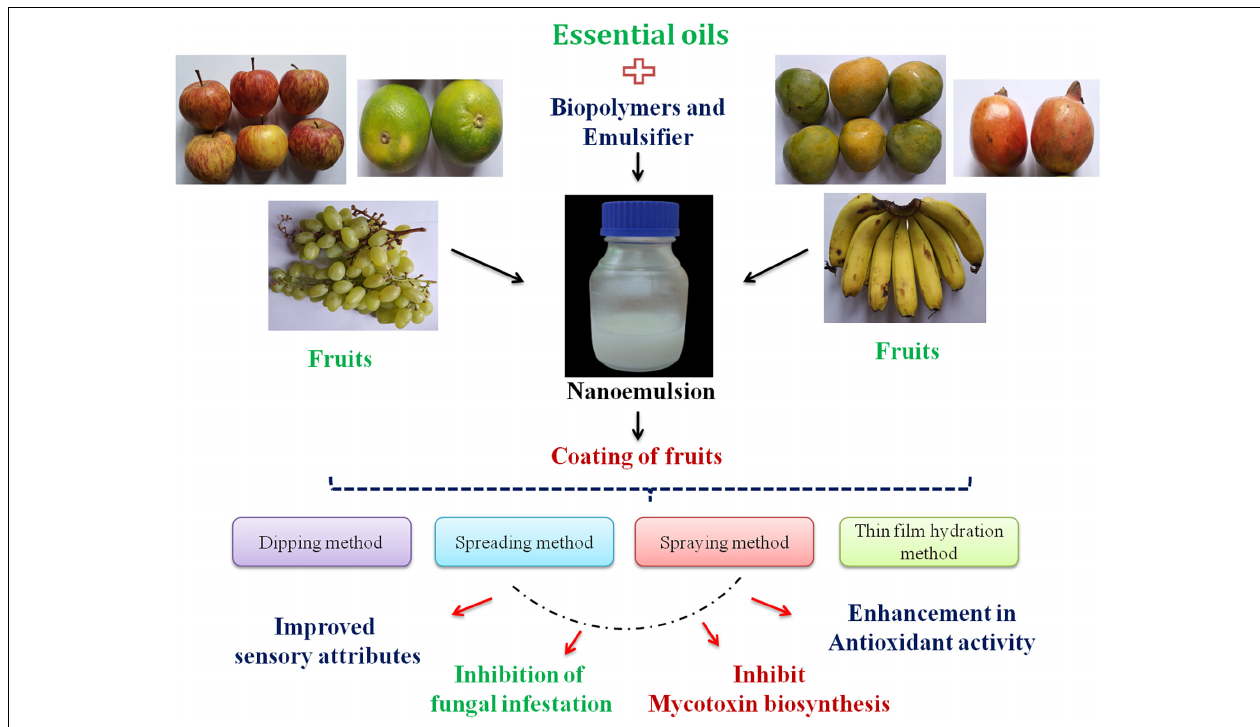
FIGURE 1 | Essential oil nanoemulsion coating of fruits by different methods and their practical application for fruit quality